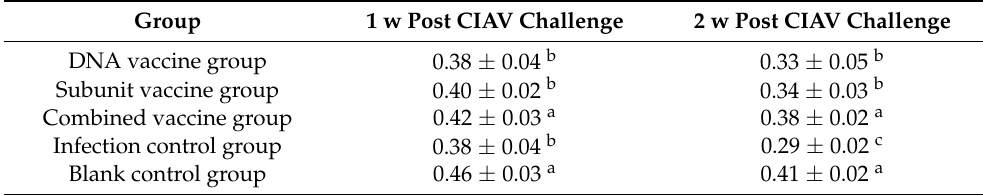
Table 5. Thymus index after CIAV Table 4. Hematocrit value (Hct) after CIAV challenge.